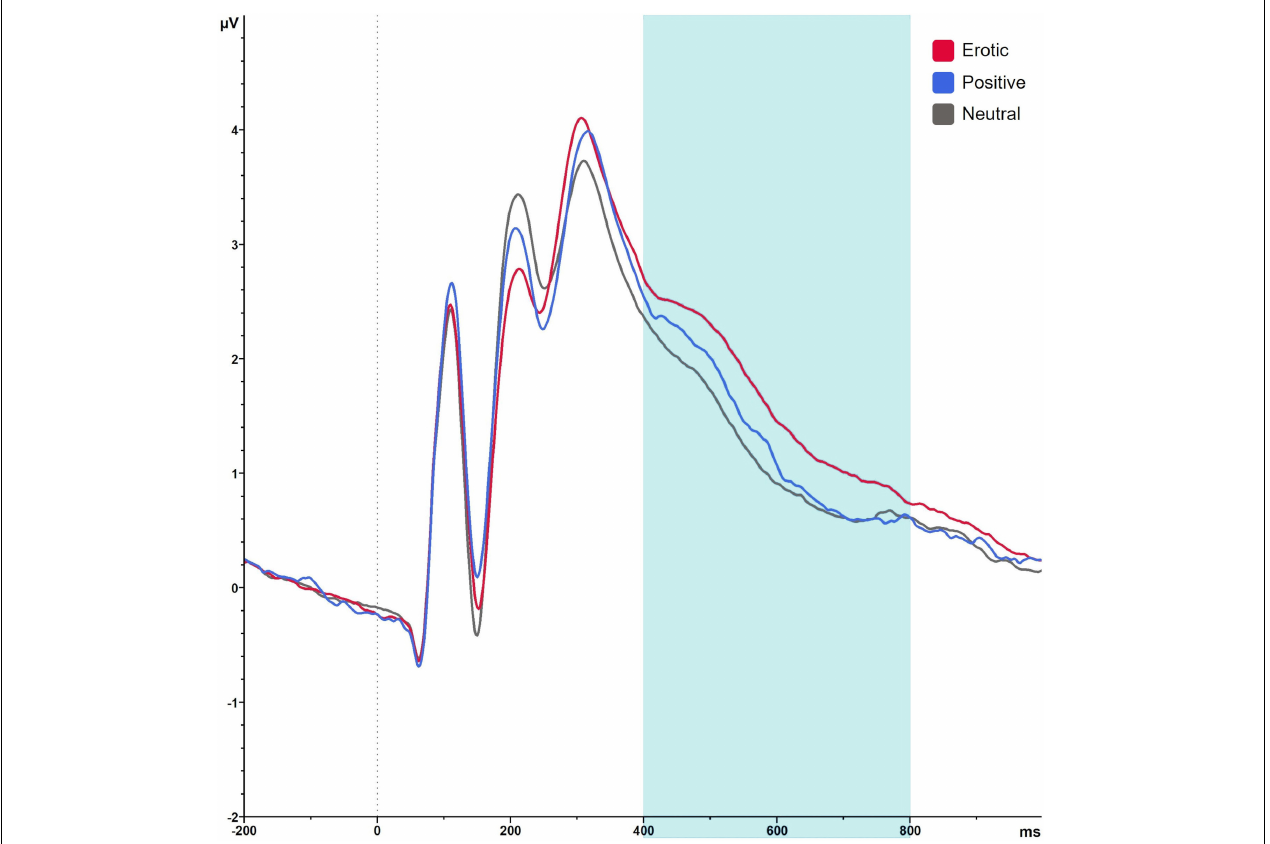
FIGURE 7 | Grand average on electrode P2 in reaction to erotic, positive and neutral stimuli in the time window 400–800 ms.